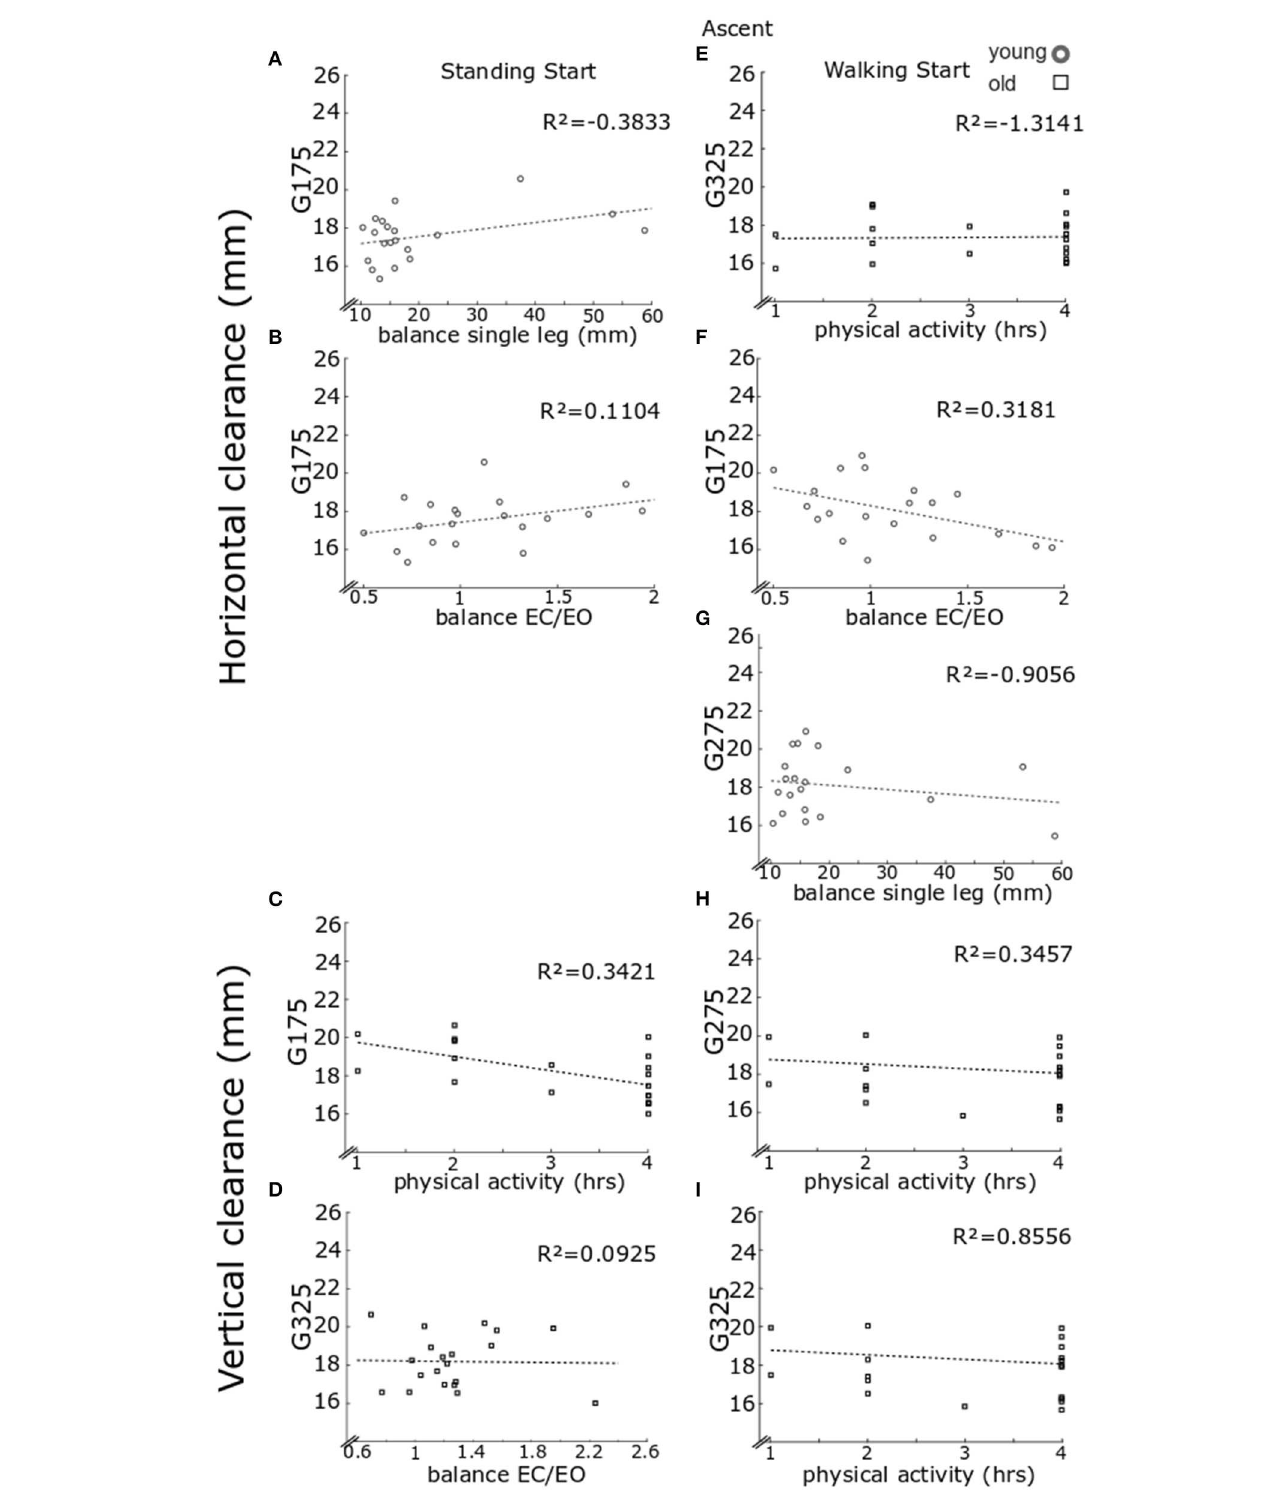
FIGURE 6 | Regression model for clearance in ascent. Lead foot clearance regression model results. Each panel reports individual data for older (black) and younger (gray) clearance in stair ascent in the horizontal direction and in the vertical direction. As only the lead foot showed significant results from the regression models,